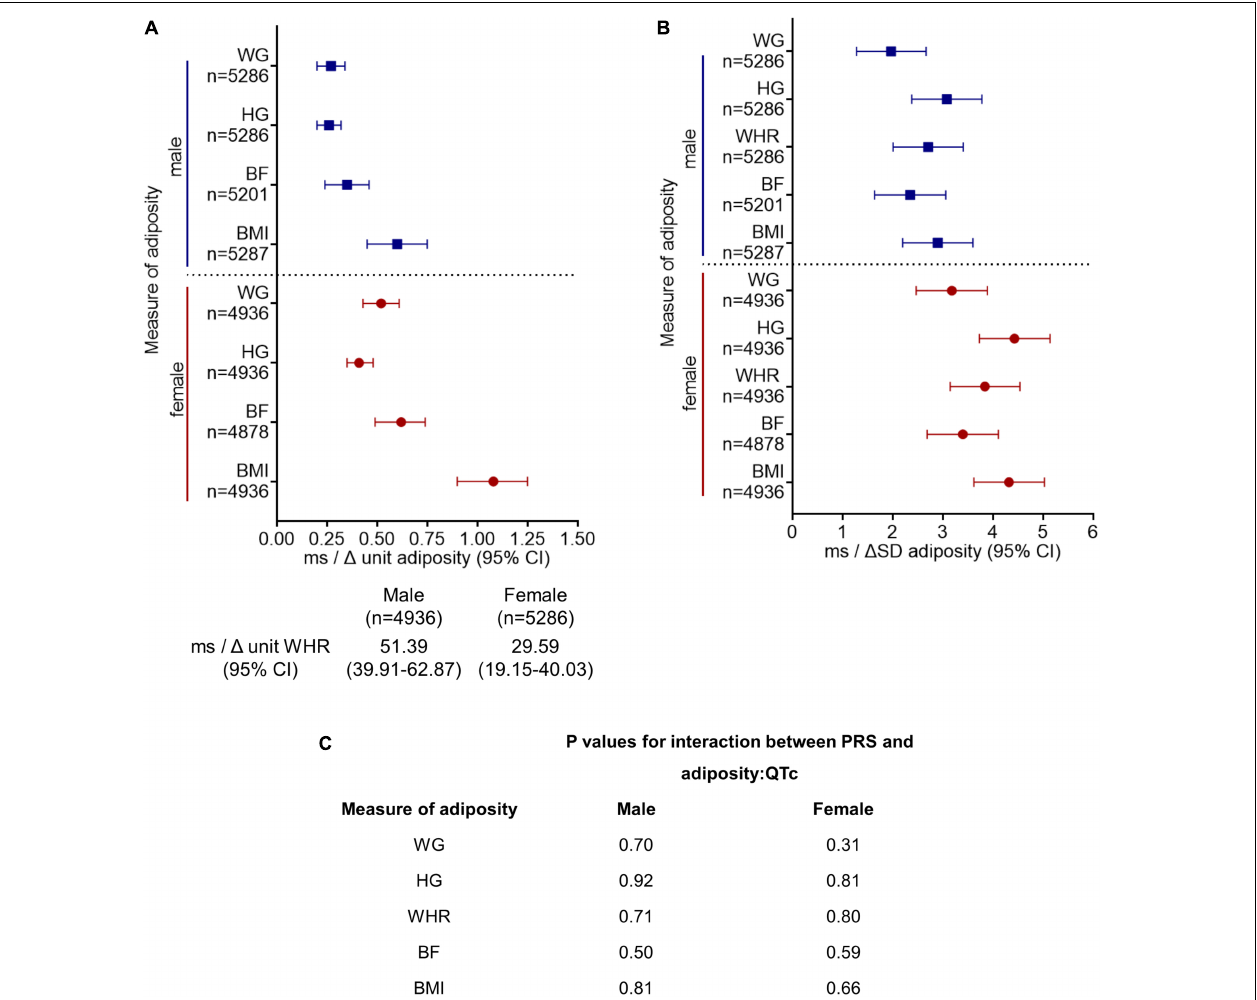
FIGURE 2 | Polygenic risk score (PRS) for genetically determined QT interval does not modulate the association between increasing adiposity and QTc interval. The change in QTc per unit (A) and per standard deviation (SD) (B) increment in adiposity [quantified by BMI, body mass index (kg/m 2 ); BF, body fat (%); WHR, waist:hip ratio (unit); HG, hip girth (cm); WG, waist girth (cm)] are shown stratified by sex. Model 3 is adjusted for PRS in addition to sociodemographic and lifestyle factors and comorbidities as in model 2 ( Figure 1 ). All results presented for model 3 in (A,B) reached significance p < 0.001. (C) There was no significant interaction